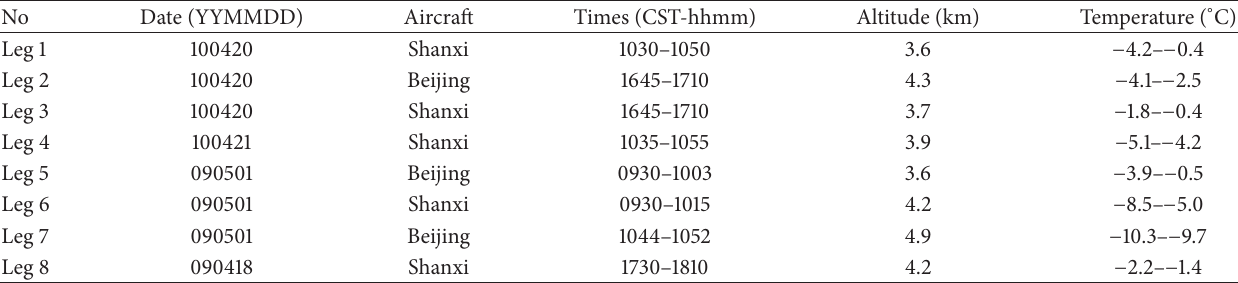
Table 1: Horizontal flight leg features, including aircraft, beginning and end times, altitudes, and cloud